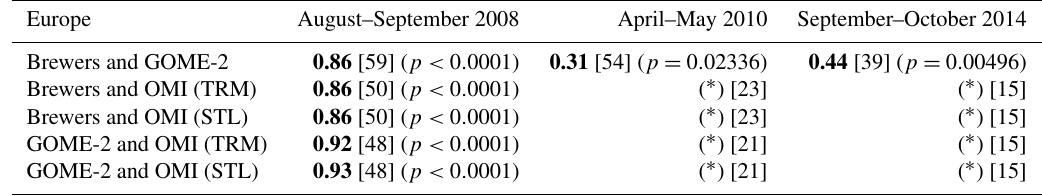
Table 5. Correlation coefficients between the mean columnar SO 2 measured by the Brewers in Europe and provided by the satellite products of OMI and GOME-2 during the volcanic eruptions of Kasatochi (2008), Eyjafjallajökull (2011) and Bárðarbunga (2014) for stations located under the volcanic SO 2 plume.